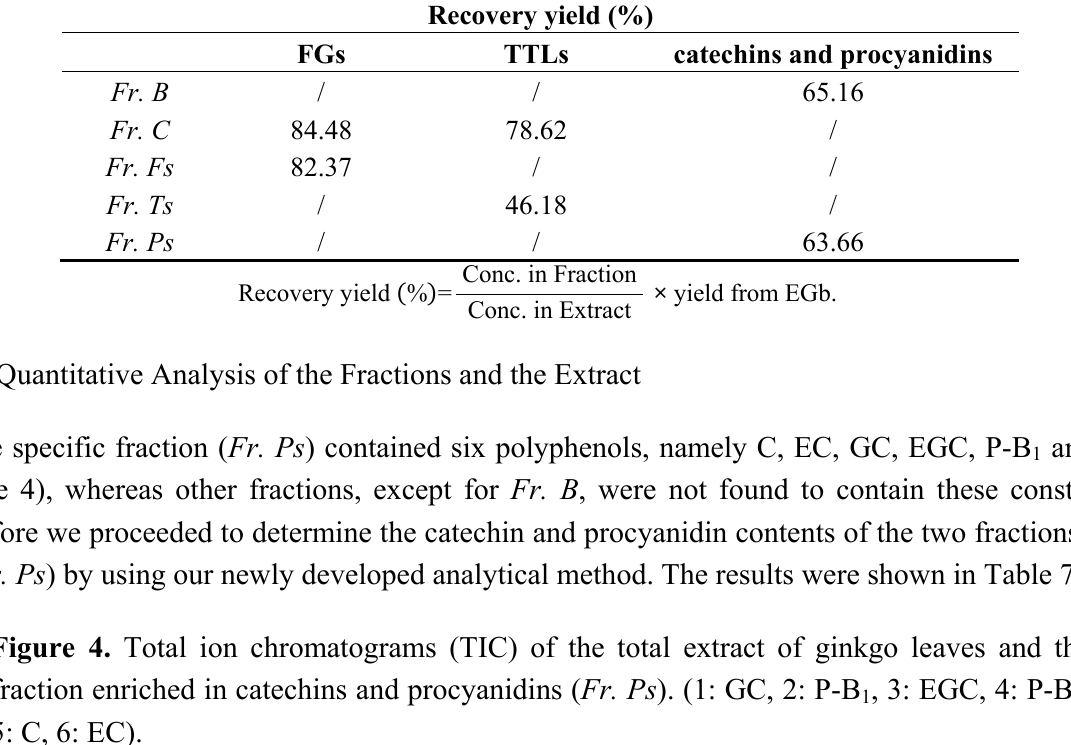
, 3: EGC, 4: P-B , 1 3